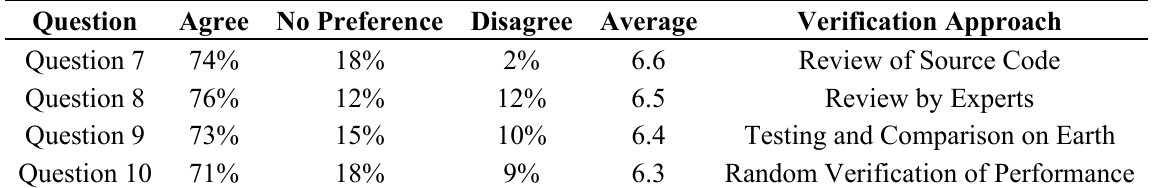
Table 17. Summary of respondent preferences for Questions 7 through